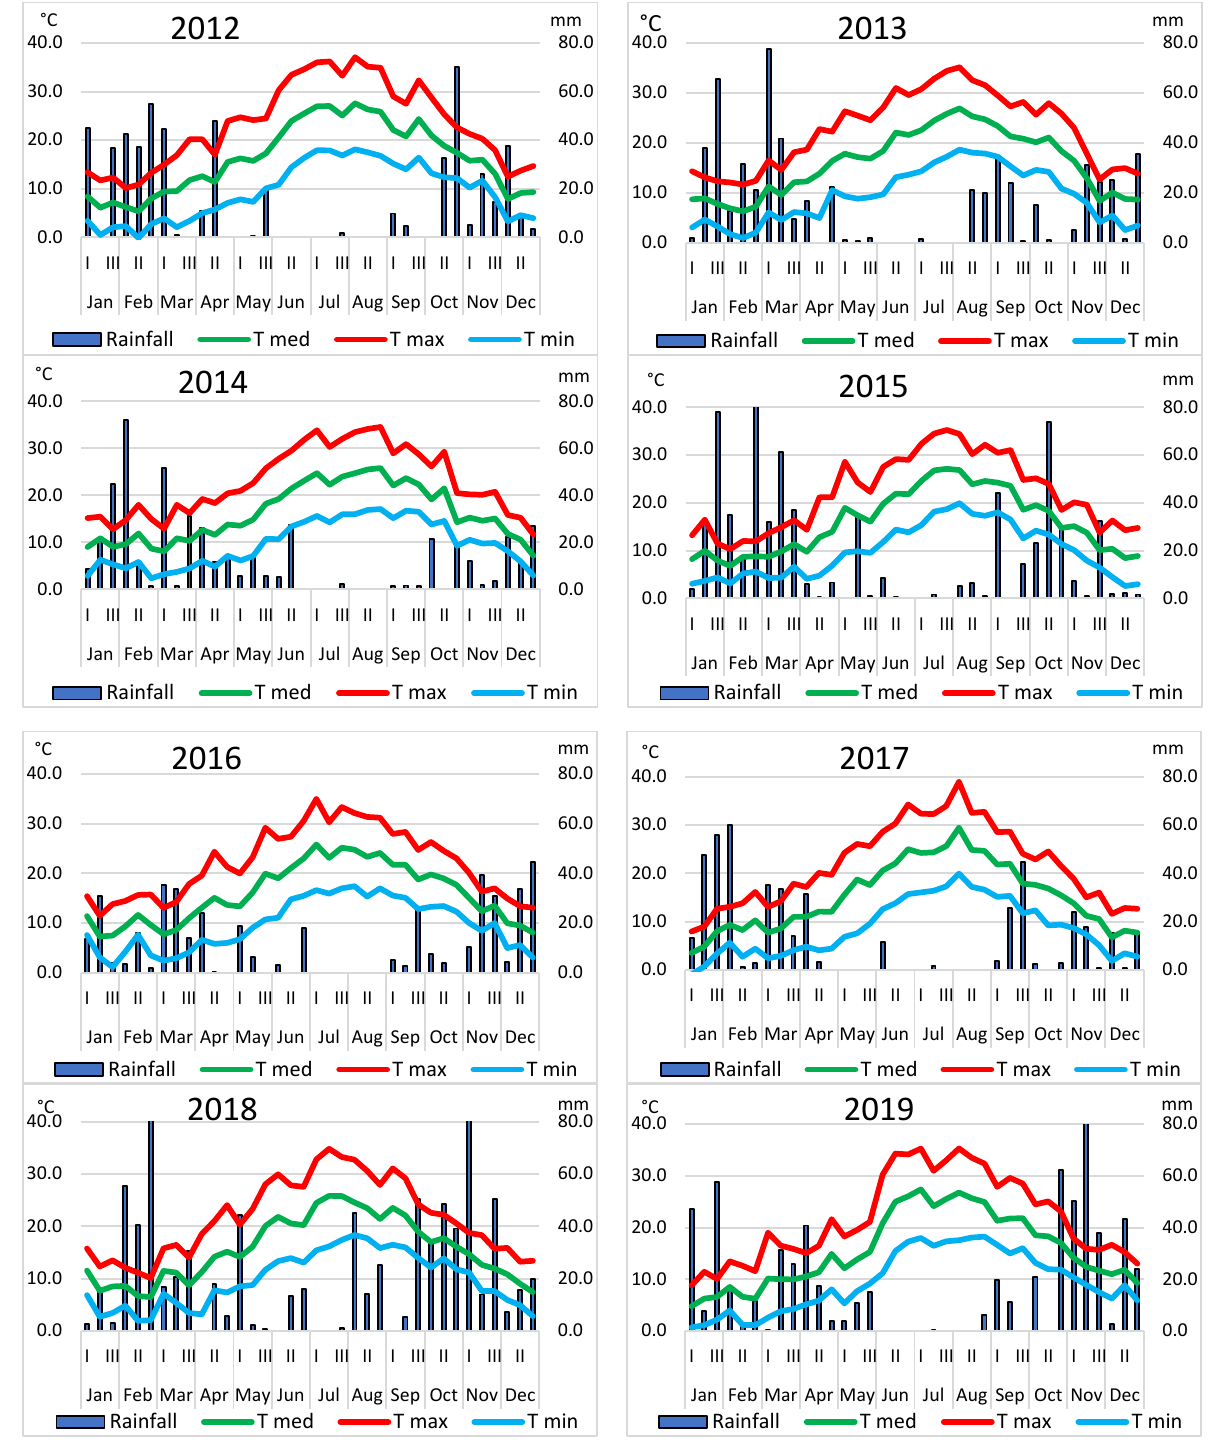
Figure 2. Ten-day values of rainfall (mm) and temperatures (minimum, maximum and mean; °C) recorded at the “Sparacia” farm (Cammarata, AG, Italy) from 2012 to 2019. Calculations were assumed to start on the 1st day of January of each year (day i) and to conclude at the appearance of flower buds (FB) and at full flowering (F; harvest time). T base , i.e., the temperature value below which plant growth is assumed to be zero, was set equal to 10 °C [18].